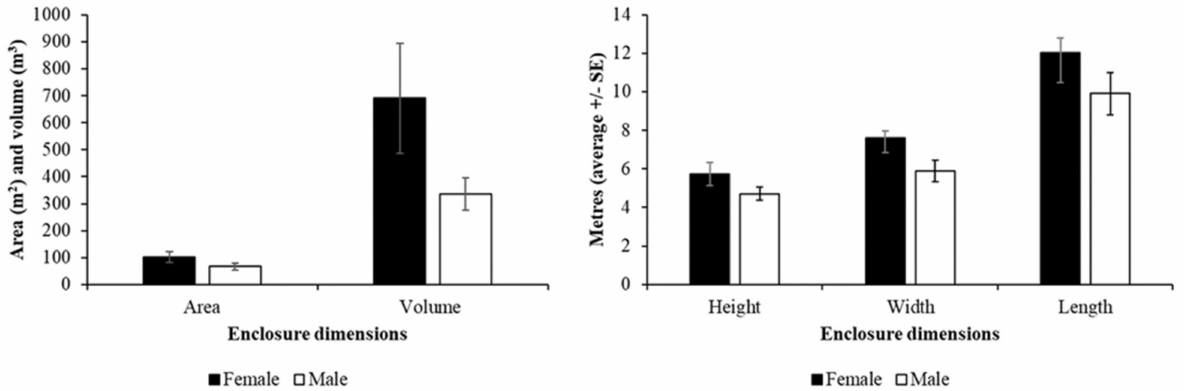
Figure 3. Mean ( ± SE) of outdoor enclosure area, volume and dimensions for male and female fossa (N = 36) were all enclosure measurements were